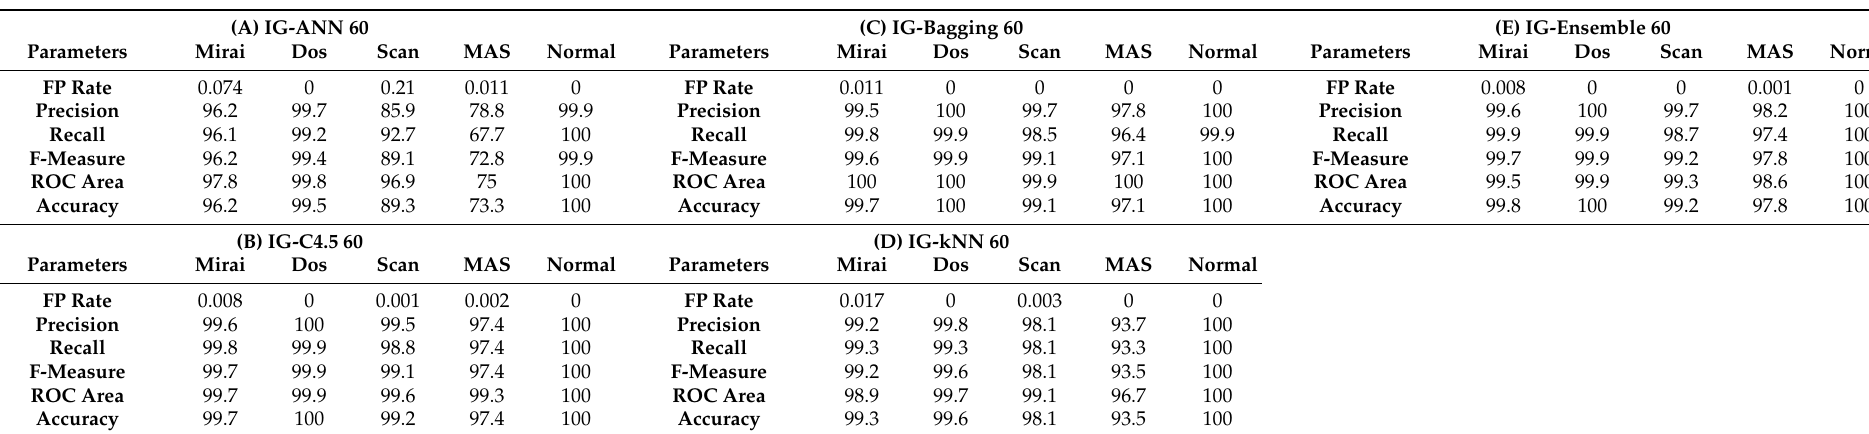
Table 9. Summary of calculated statistical parameters for test IoTID20 dataset using IG with top-ranked 60 features.